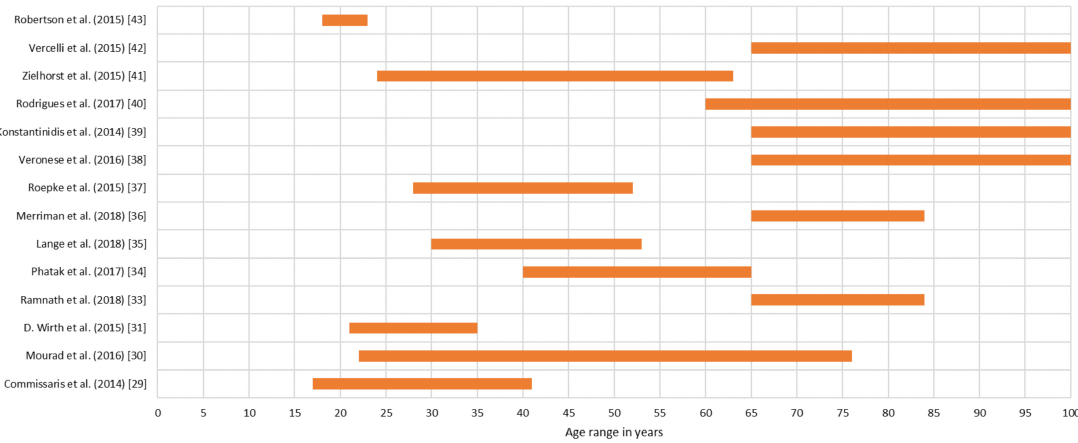
Figure 8. Age range of each